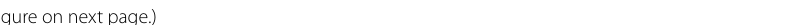
0.05)(See figure on next Fig. 5 Soil C, N, DOC concentrations and C/N during the 540-day root decomposition of different branch orders of the two species. RO1–2 refers to the 1st- and 2nd-order roots, RO3, RO4 and RO5 refer to the 3rd-, 4th- and 5th-order roots, respectively. Error bars represent was conducted to compare the differences between roots of different branch orders with decomposition time as the covariate. Different letters at the end of the curves indicate significant differences between two root-order classes ( P